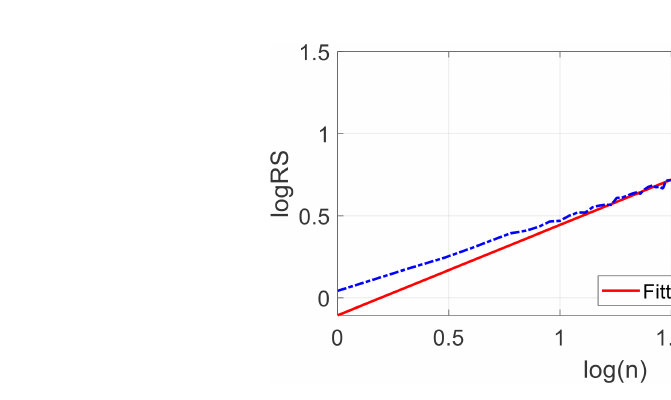
FIGURE 2 The fi tted regression lines of the Hurst